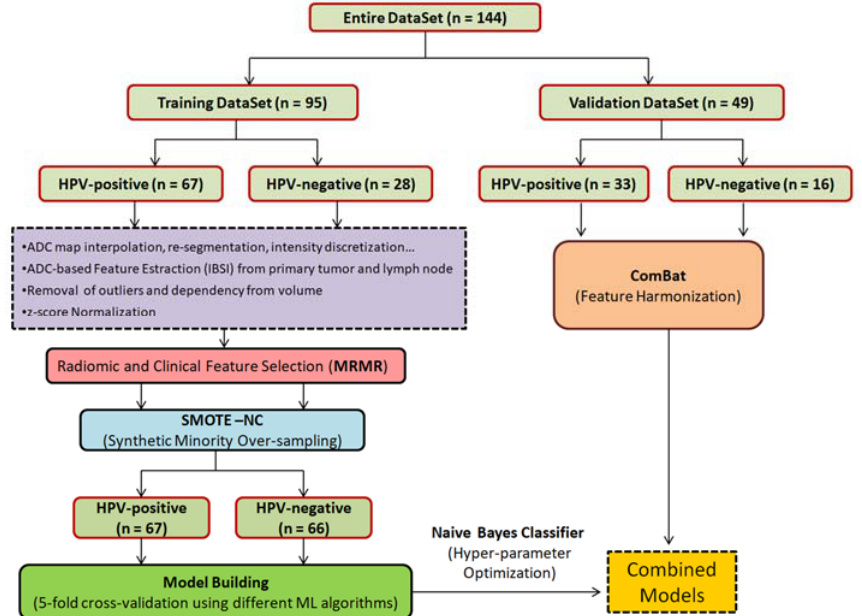
Figure 1. Data analysis pipeline.